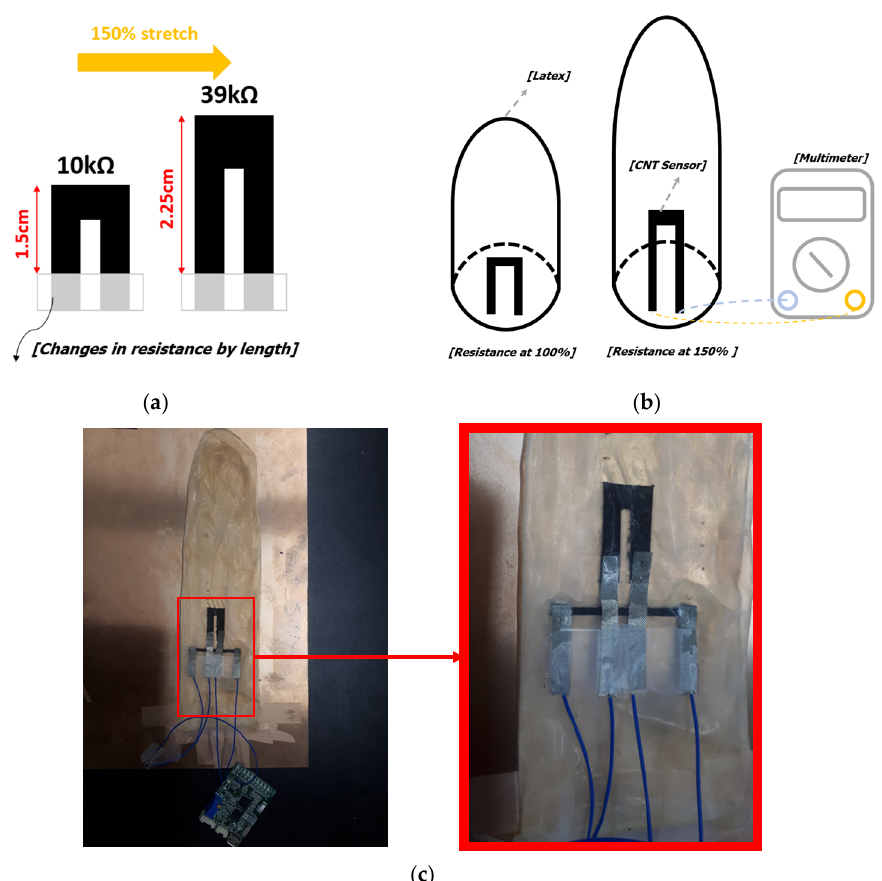
Figure 8. Changes in resistance according to changes in length: ( a ) Measurement of resistance change at 150% length change; ( b ) Measurement of resistance according to length of the CNT sensor; ( c ) CNT sensor-based measurement prototype configuration.